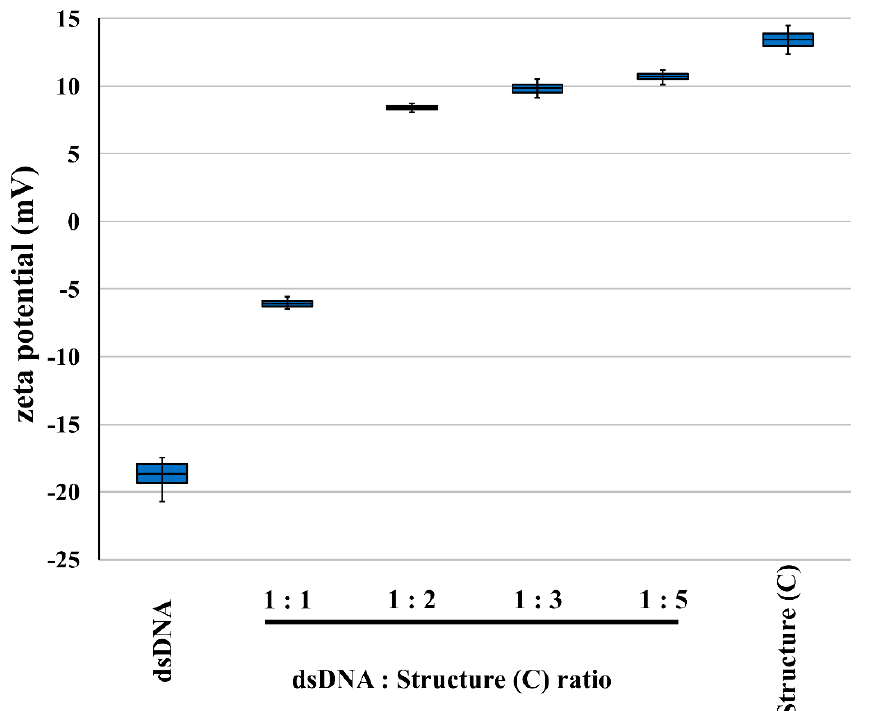
Figure 2. Zeta potentials of dsDNA and PAMAM [G5:G3-(TREN)]- N -(4-carbomethoxy) pyrrolidone terminated tecto(dendrimer) (Structure (C)) solutions and their respective dsDNA: PAMAM [G5:G3-(TREN)]- N -(4-carbomethoxy) pyrrolidone terminated tecto(dendrimer) (Structure (C)) polyplexes formed at different DNA to dendrimer weight ratios. All data were measured at 25 °C. Error bars represent minimal and maximal values; boxes represent standard error of mean ( n = 4).